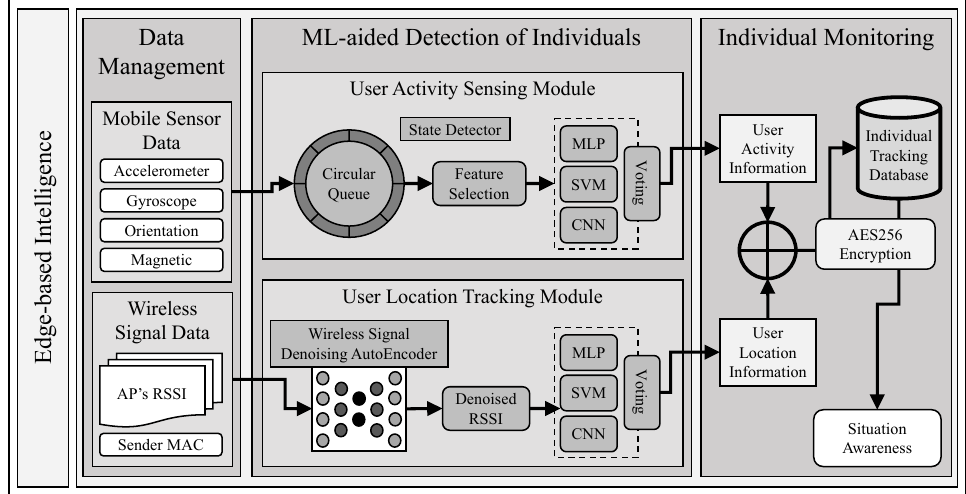
Figure 5. E-IMS framework in an edge